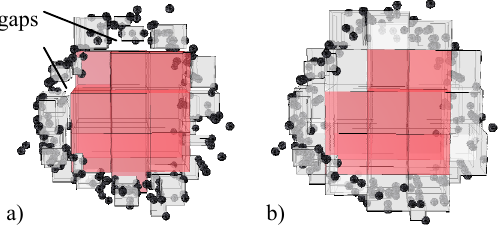
Figure 4. a) Bounding boxes with gaps and occluded voxels; b) Expanded bounding boxes with occluded voxels